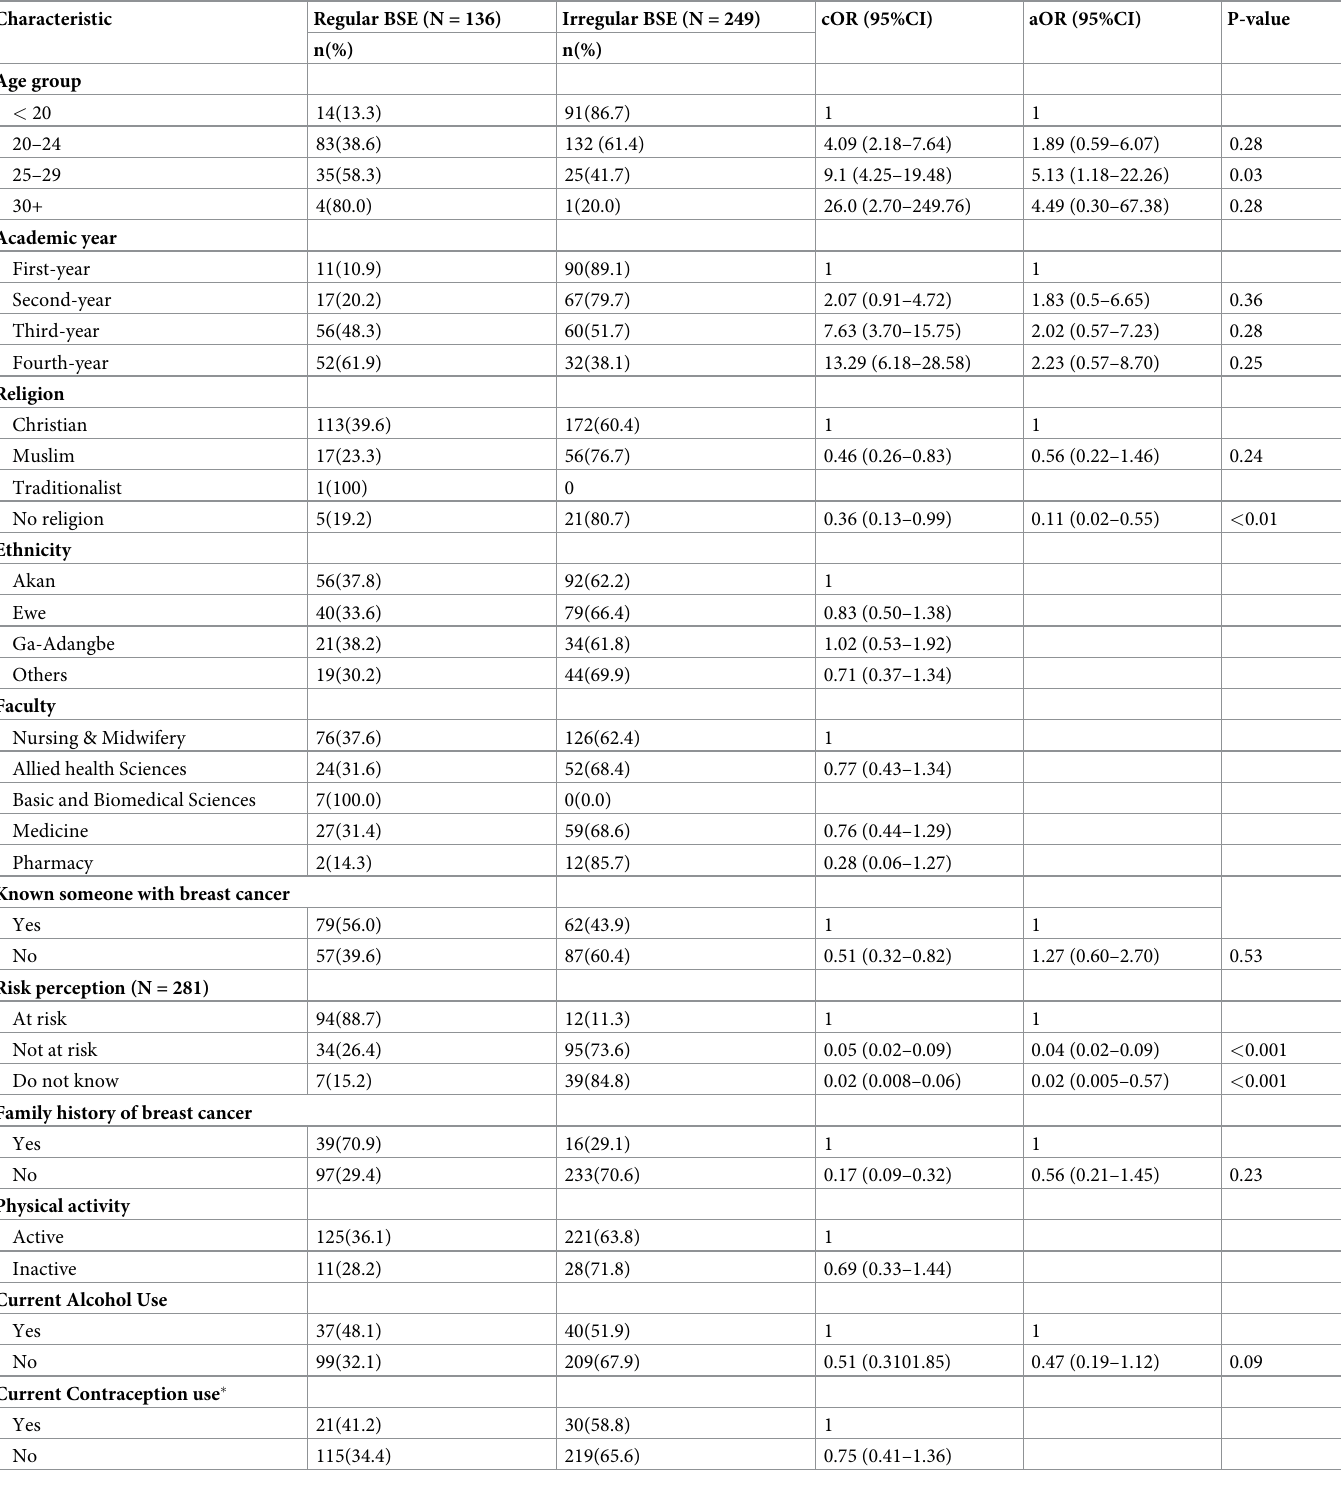
Table 6. Logistic regression analysis of predictors of regular breast self-examination for breast